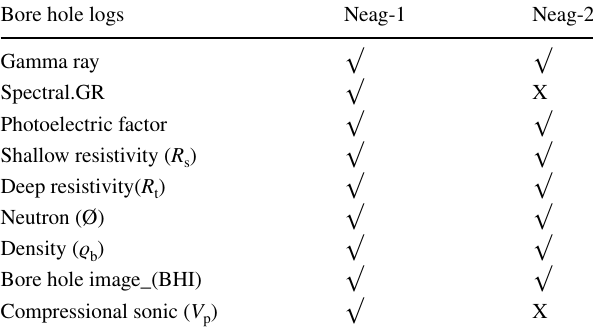
Table 1 Summary of available well log data